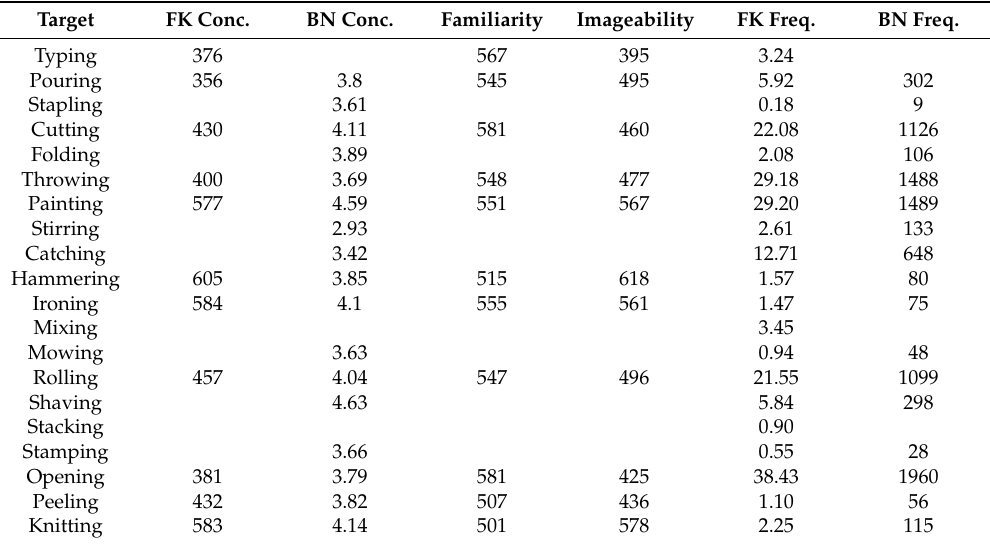
Table A1. Action Verbs and Psycholinguistic